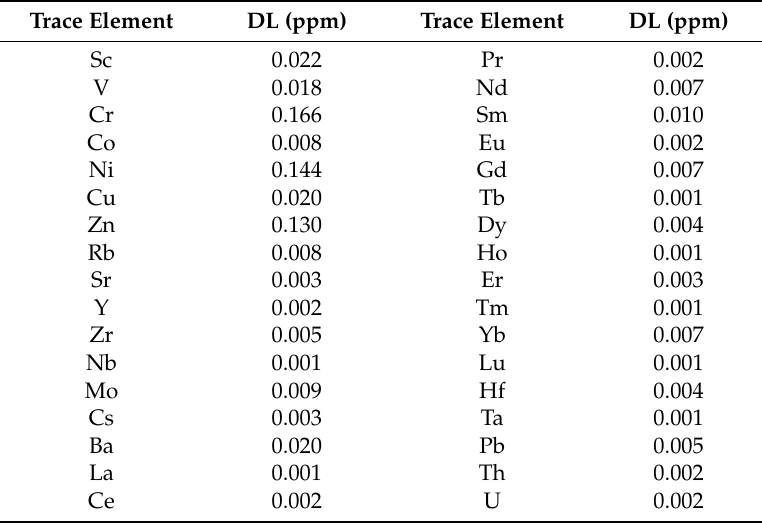
Table 2. Instrument detection limits (DL) of trace